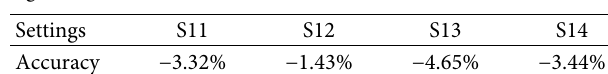
Table 2: Performance decrement ( − )/increment (+) of different algorithms on